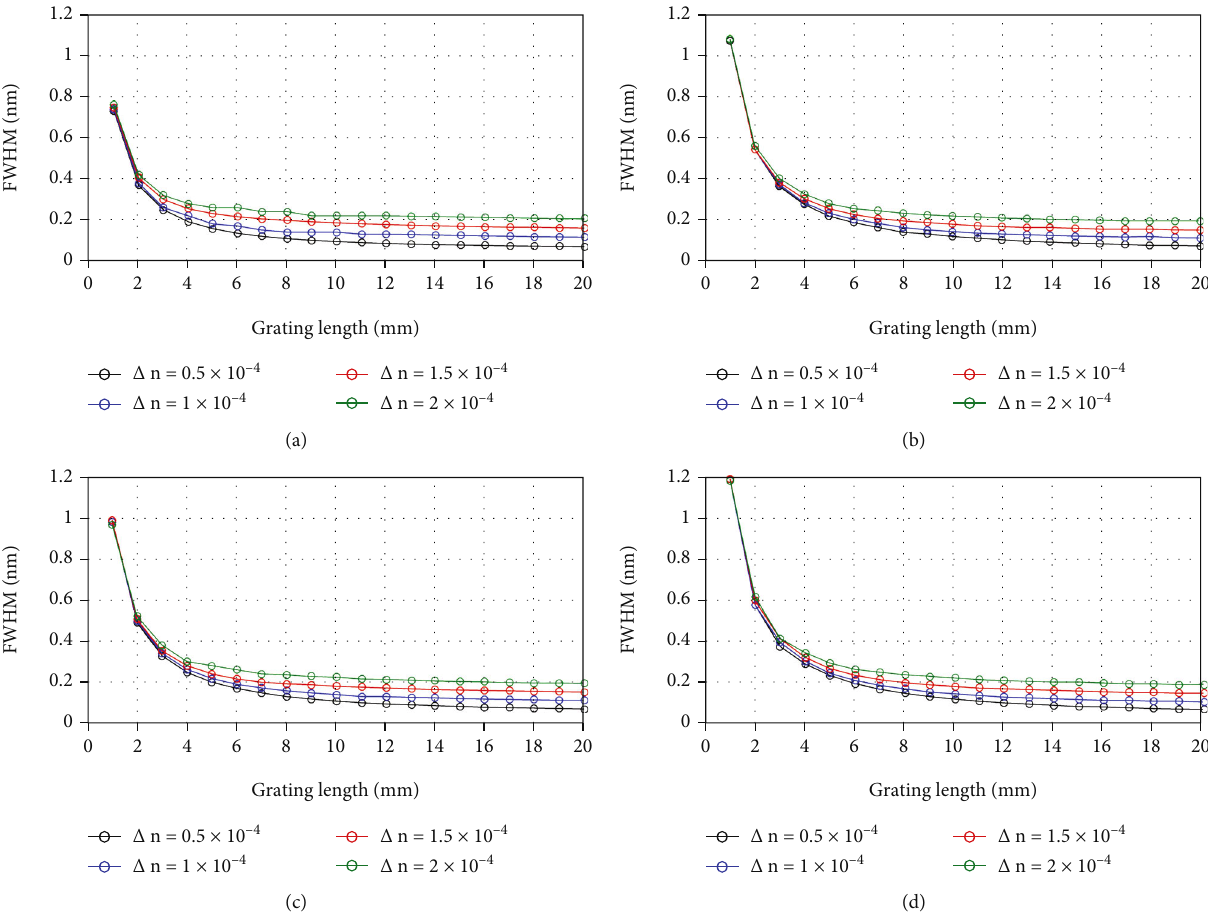
Figure 7: Comparison of FWHM versus grating length of FBG with (a) uniform, (b) Gaussian, (c) sine, and (d) raised sine (30 to 32dB) are shown by raised sine apodized FBGs. As we can see in Figure 10, Gaussian apodization Uniform fi ber Bragg grating provides the least side-lobe ensures the highest SLS (33 to 38 dB) results when 1 mm suppression values when grating lengths are used in the to 7 mm grating lengths are chosen, but when grating range of 1 mm to 20mm. lengths are between 9 mm to 20 mm, the best SLS results